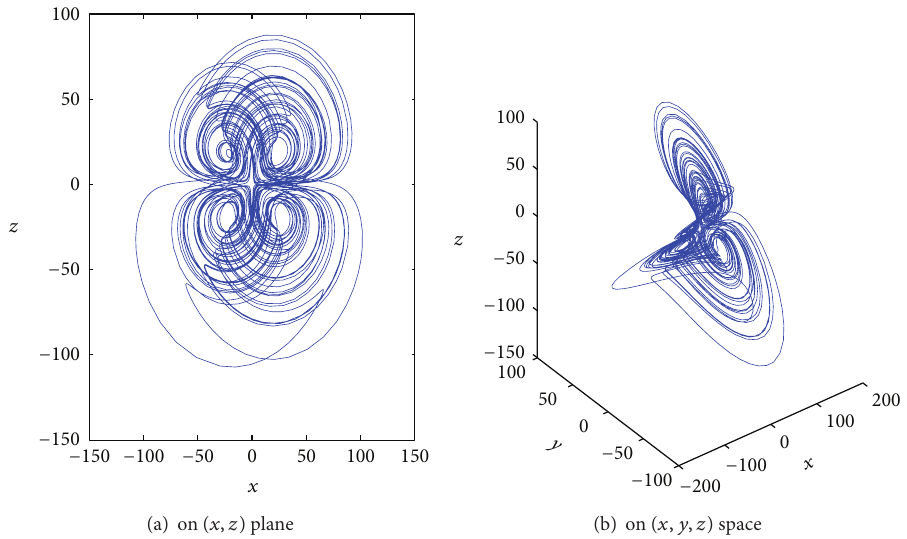
Figure 2: The four-wing hyperchaotic attractors of real Dadras system (4) for 𝛼 = 8 , 𝛽 = 40 , and 𝛾 = 14.9